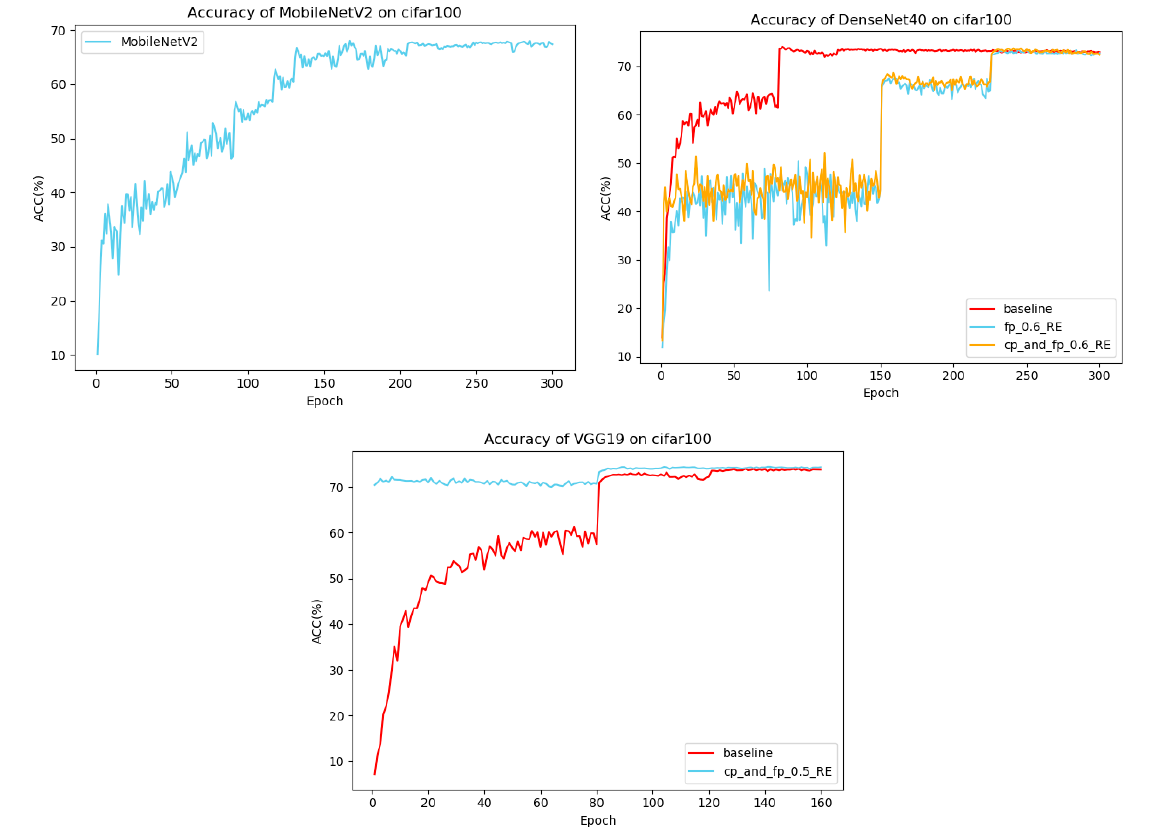
Figure 4. Changes of accuracy of Densenet40, VGG19 and MobileNetV2 on CIFAR100 data set.